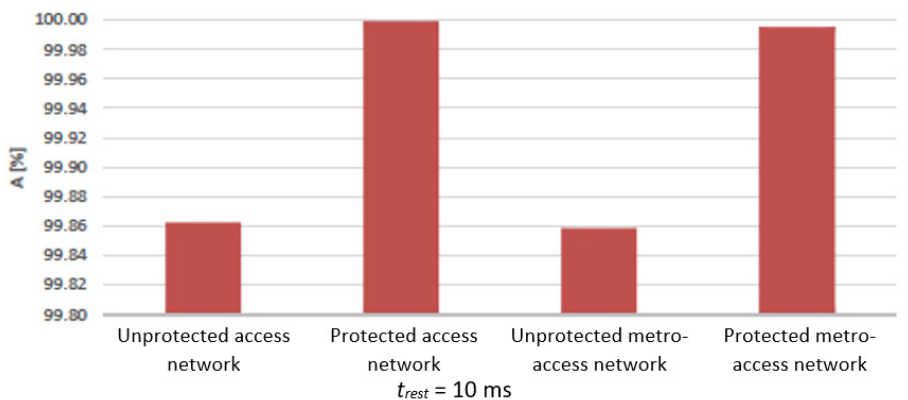
Figure 9. The network availability of RING WDM-PON protection scenarios for the selected restora- tion time.